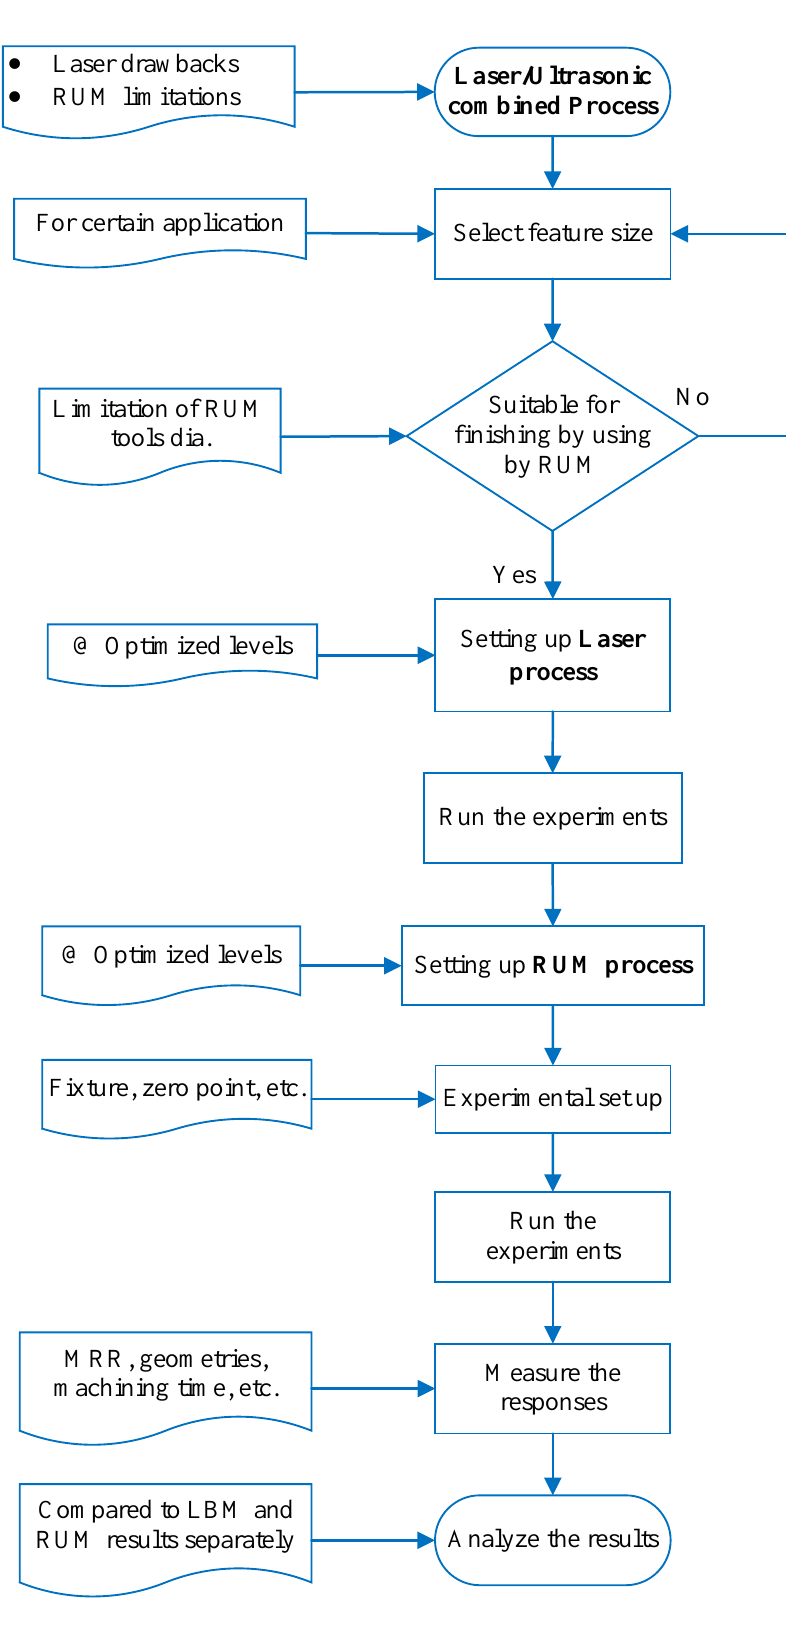
Figure 5. Workflow adopted in this study.